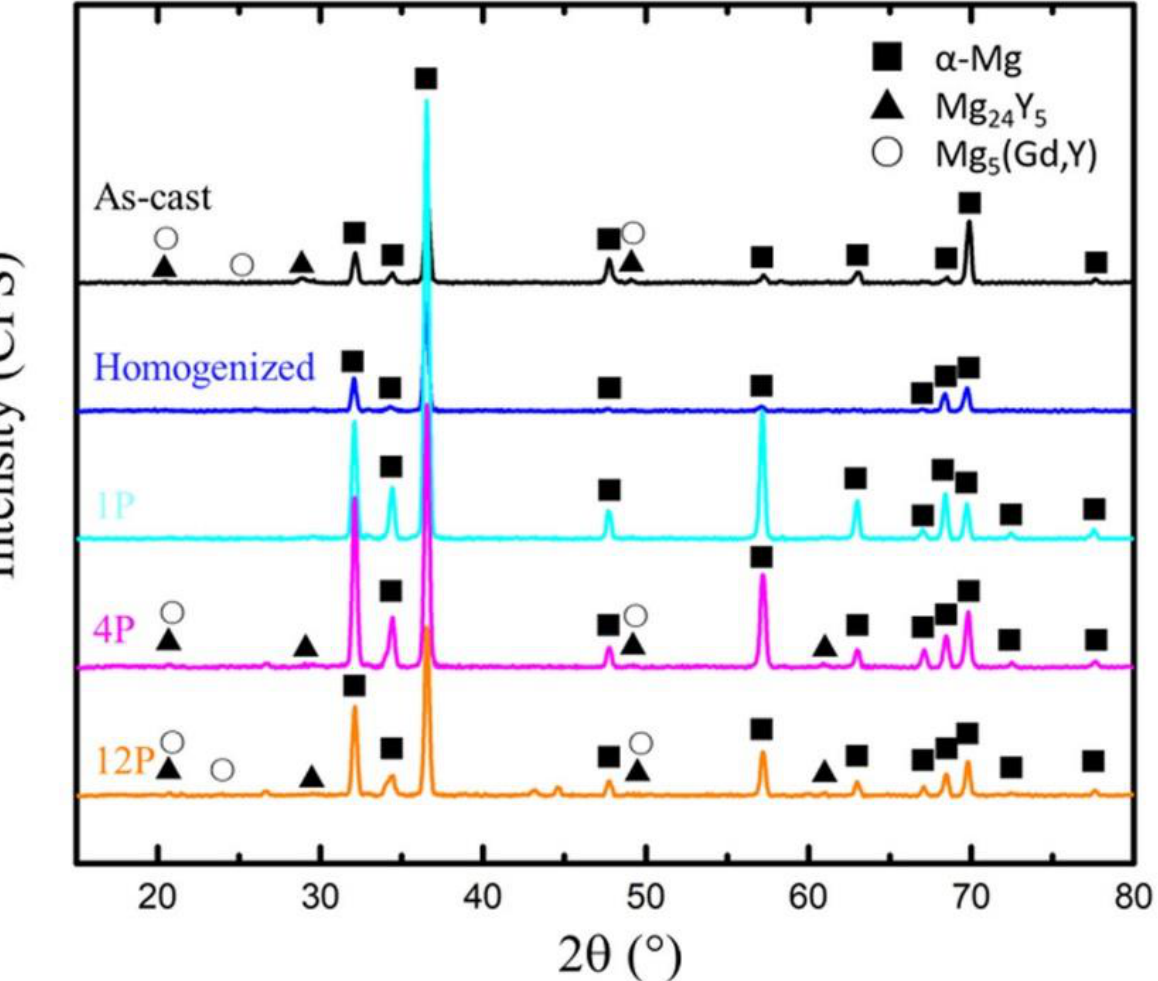
Figure 3. Phase composition of GW103 samples in different processing conditions.